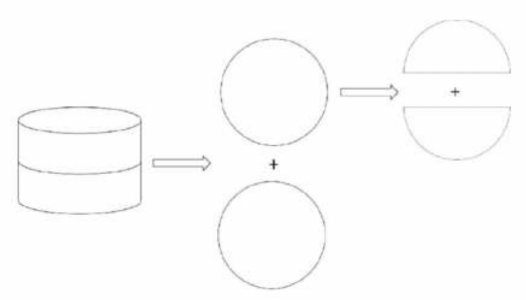
Figure 1. Sample preparation.